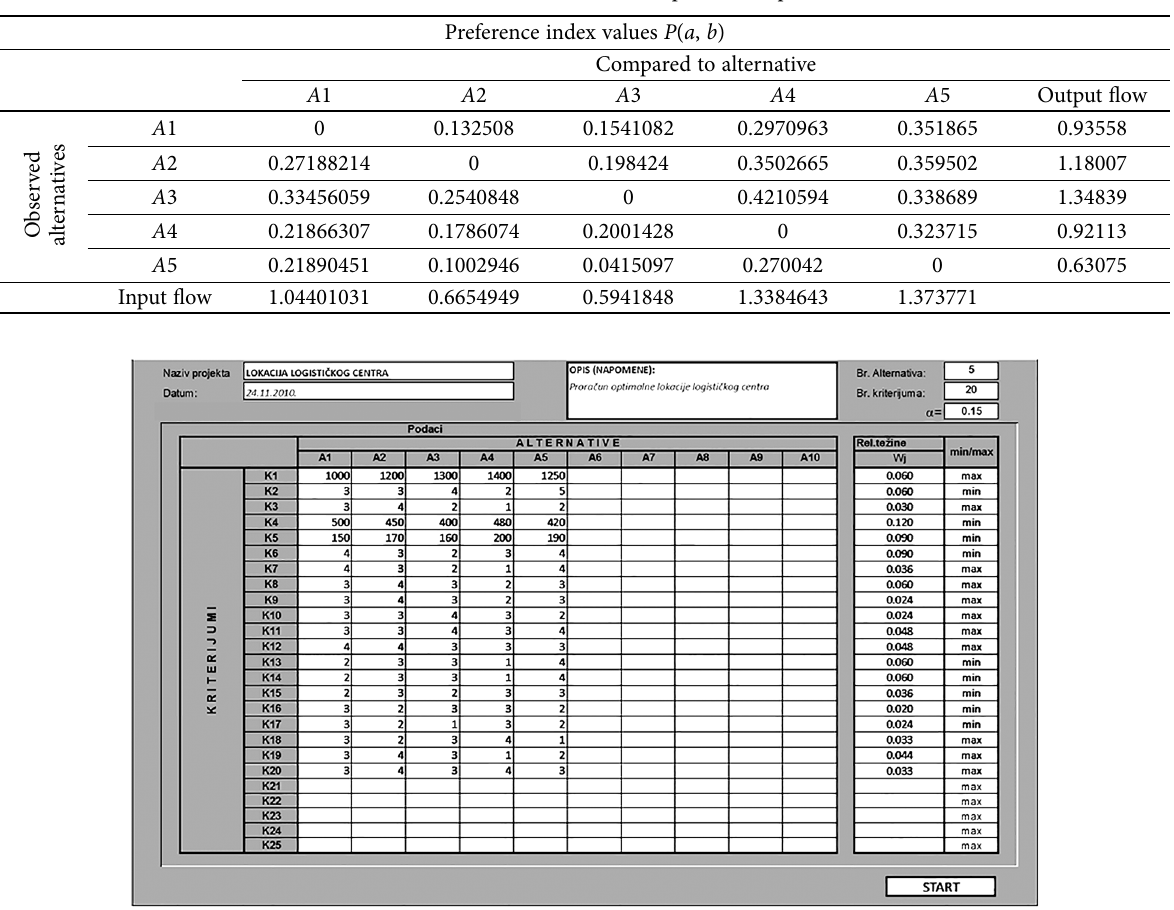
Table 4 . Preference index values with input and output flows